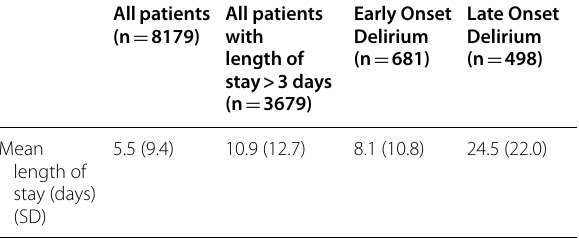
Table 1. ICU mean length of stay (all patients vs patients with positive